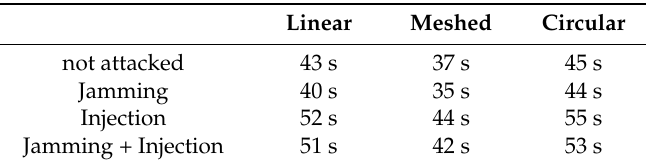
Table 6. Execution time of the simulator.